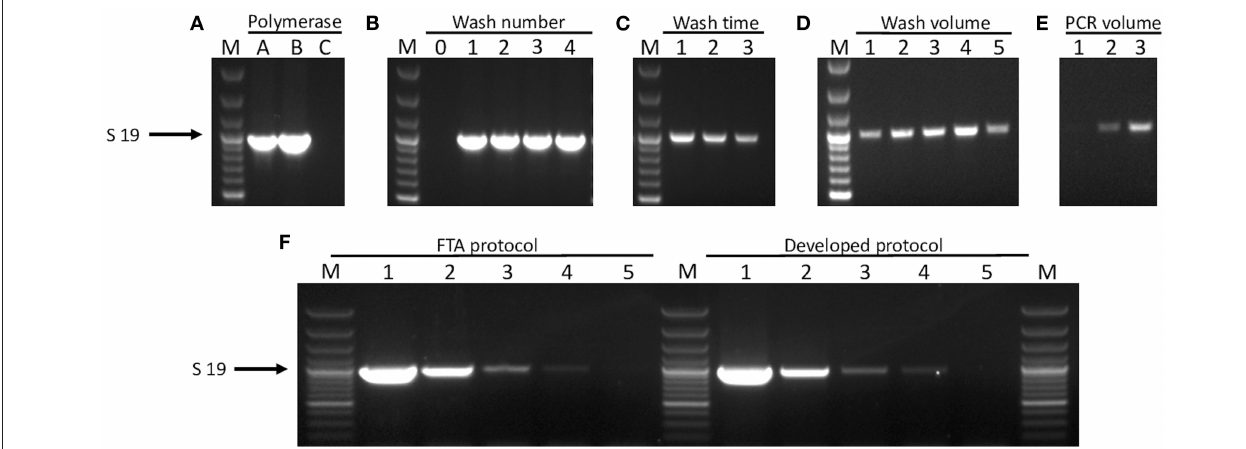
FIGURE 1 | Optimization of FTA ® card processing for direct PCR amplification. FTA ® card discs inoculated with reference strain 7213384-1 at OD 600 = 0.01 producing serovar 19-specific product are shown for different optimization conditions. (A) PCR amplification from FTA ® cards using different polymerases: A